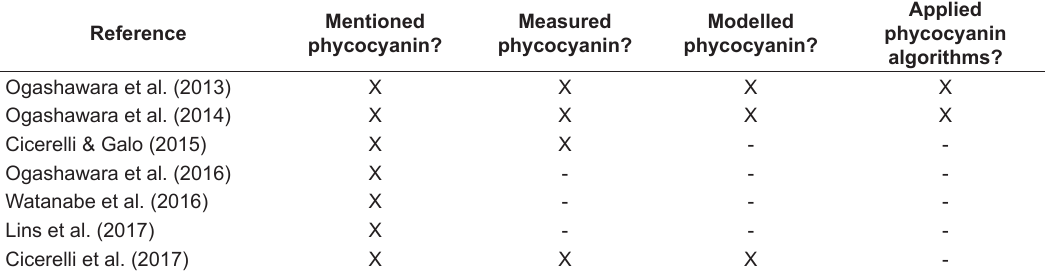
Table 1. List of Brazilian research articles (listed on the Web of Science database) and how they interact with PC.